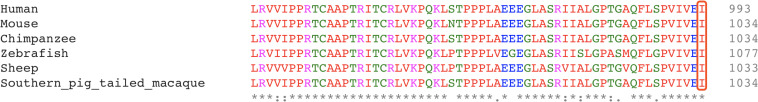
Sequencing alignment of residue I993 in ANK1 protein. Result shows that this residue is extremely conserved among species.